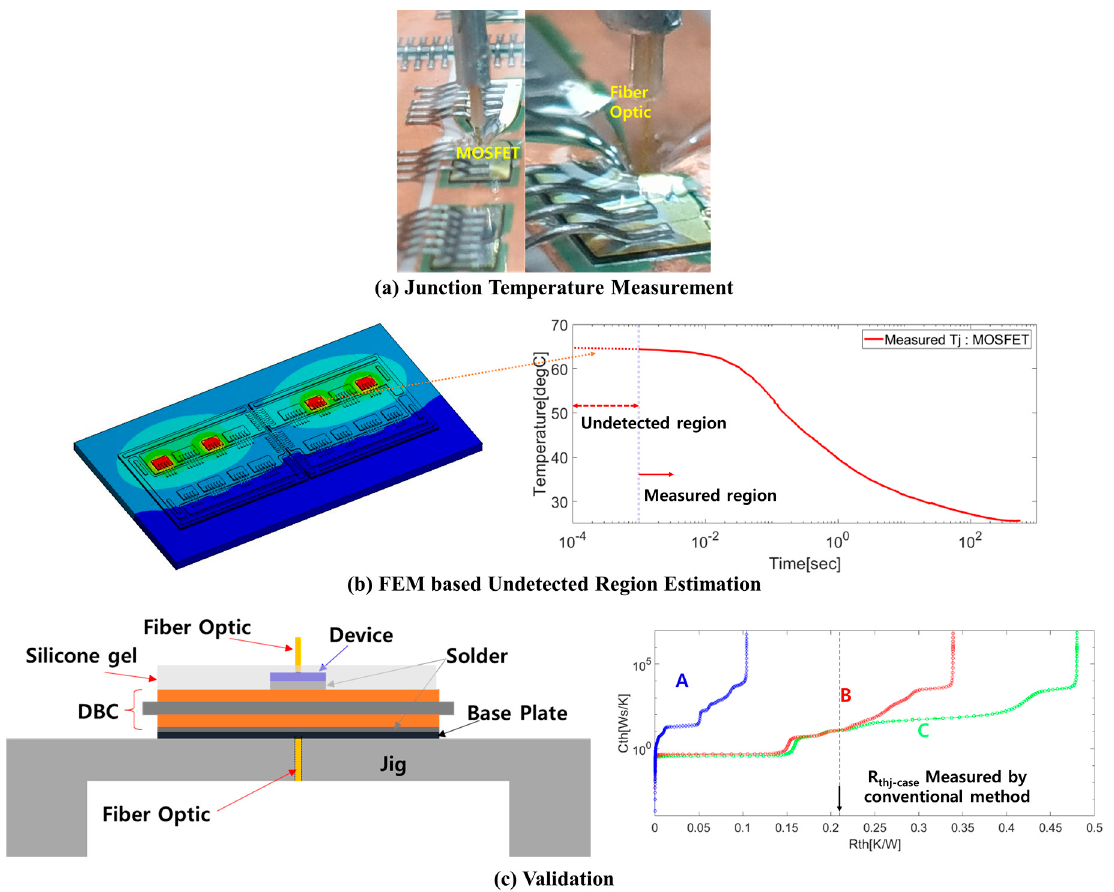
Figure 2. ( a ) Image of the fiber optics on the SiC MOSFET. ( b ) Conceptual image of the undetected region compensated for by the FEM. ( c ) Schematic of the conventional measurement for validation. The graph in ( c ) shows the structure functions obtained by the TSEP and proposed methods (A: structure function based on the TSEP; B: structure function based on the proposed method with thermal grease; C: structure function based on the proposed method without thermal grease).